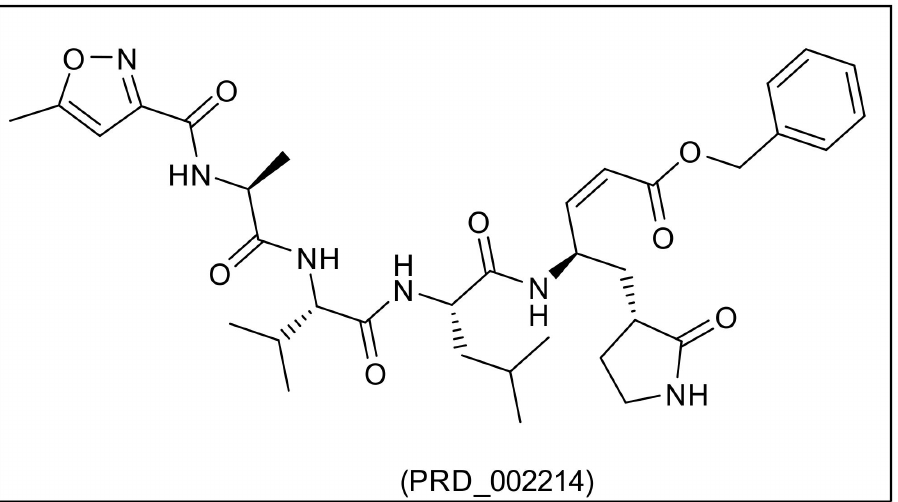
Figure 2. The chemical structure of PRD_002214